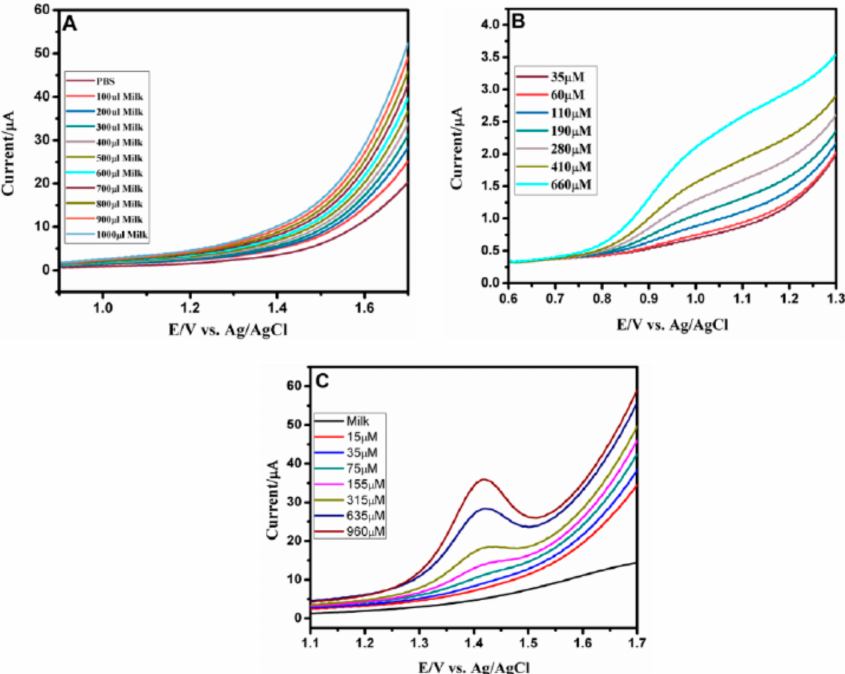
Figure 10. SWVs for determination of nicotine and ca ff eine in milk samples with: ( A ) without spiking of nicotine and ca ff eine at HA-MWCNT-GN / GCE in 0.1MPBS at pH 7.0. ( B ) Standard addition of known concentration of nicotine from 35 µ M to 660 µ M at HA-MWCNT-GN / GCE in 0.1MPBS at pH 7.0. ( C ) Standard addition of known concentration of ca ff eine from 15 µ M to 950 µ M at HA-MWCNT-GN / GCE in 0.1MPBS at pH